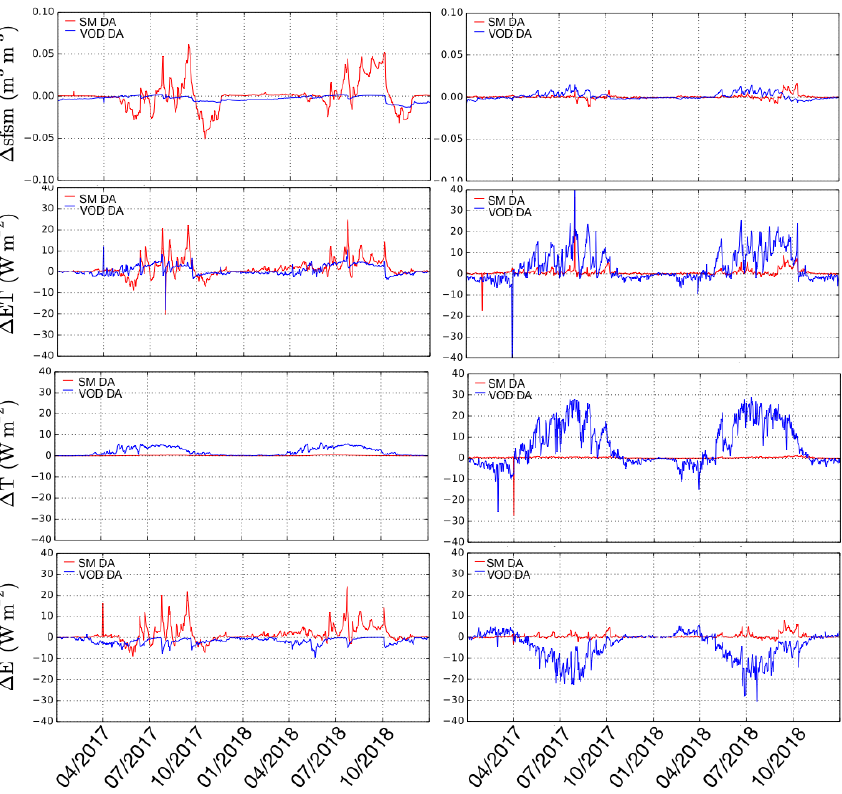
Figure 11. Time series of changes (relative to the OL) in ET, surface soil moisture, transpiration, and bare soil evaporation for years 2017 and 2018, at locations C (western U.S.) and D (eastern U.S.). The left- and right-hand columns represent locations C and D,